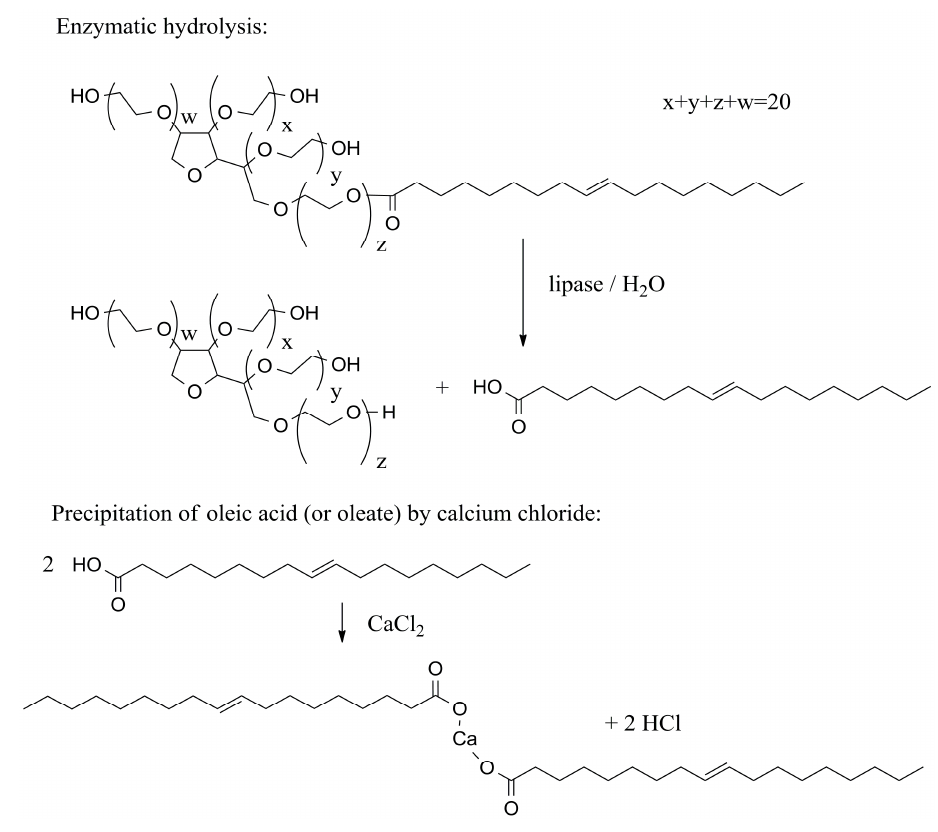
Figure 2. The lipase assay using tween 80 and calcium chloride. The arising calcium oleate can scatter